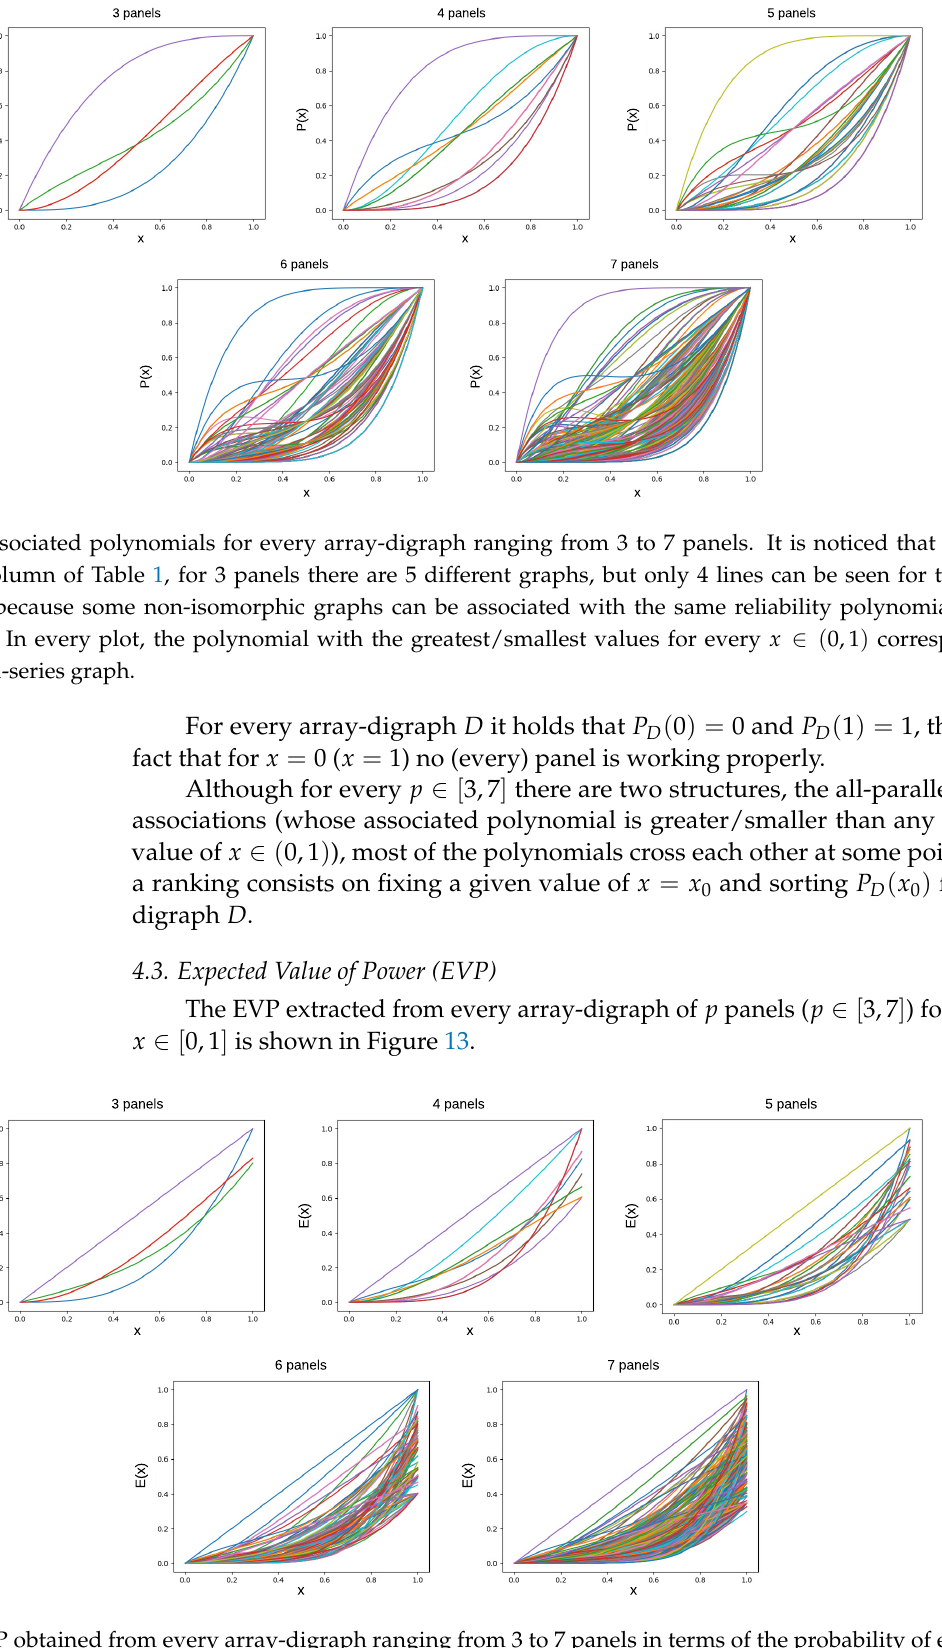
Figure 13. EVP obtained from every array-digraph ranging from 3 to 7 panels in terms of the probability of every single panel working properly. As in Figure 12, different (non-isomorphic) graphs can be assigned the same polynomial, and the number of lines may not match the numbers in Table 1 due to